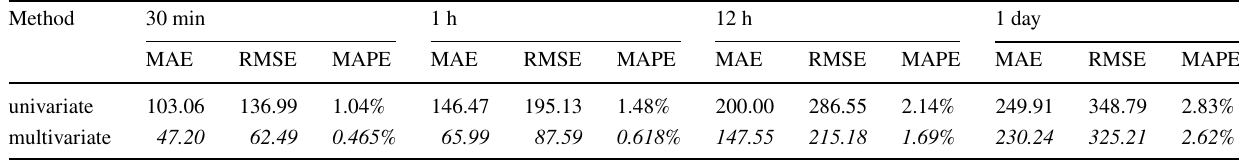
Italic values are the best results on traditional and deep